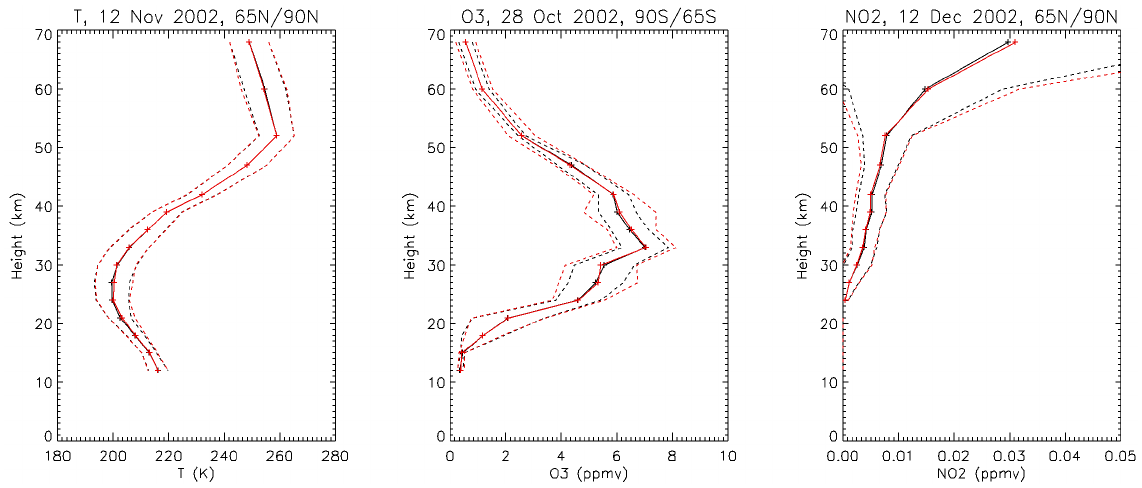
Fig. 7. Consistency between the results of the NOM and GRD datasets adopting different horizontal grid. Black lines represent the NOM data and red lines the GRD data. Solid lines represent the averaged values and dashed lines represent their standard deviation. Weighted ESDs are shown with horizontal lines at each altitude. Left panel: temperature at the North Pole in November 2002. Centre: ozone at the South Pole in late October 2002. Right: NO 2 at the North Pole in December 2002.